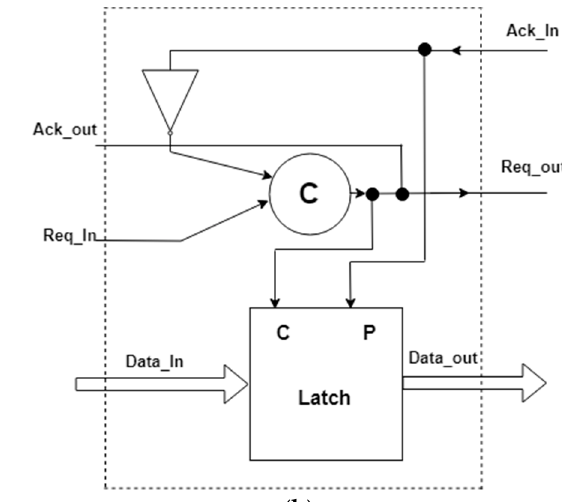
Figure 5. The internal design for the control subrouter with the arbiter, crossbar, input and output units.